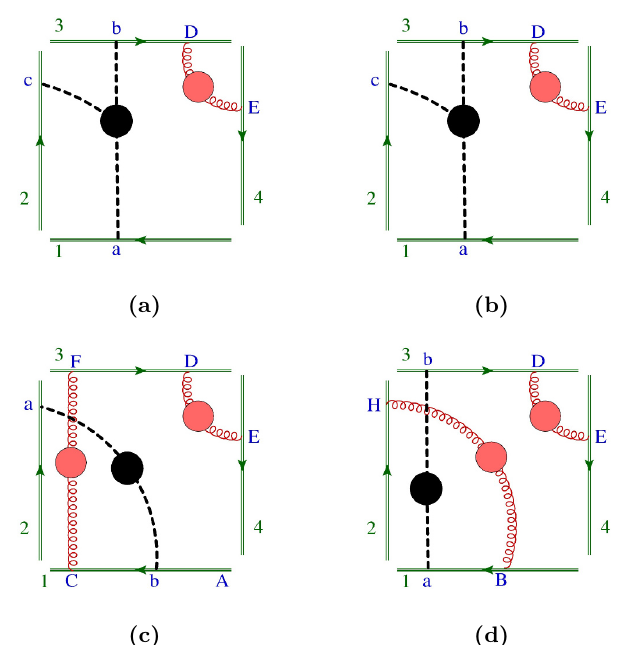
(1 , 1 , 2 , 4) . Figure 31. Fused-Webs for Cweb W (4) 4 Entanglement Diagrams of Fused-Web Diagrams in s -factors R Cweb Fused-Web